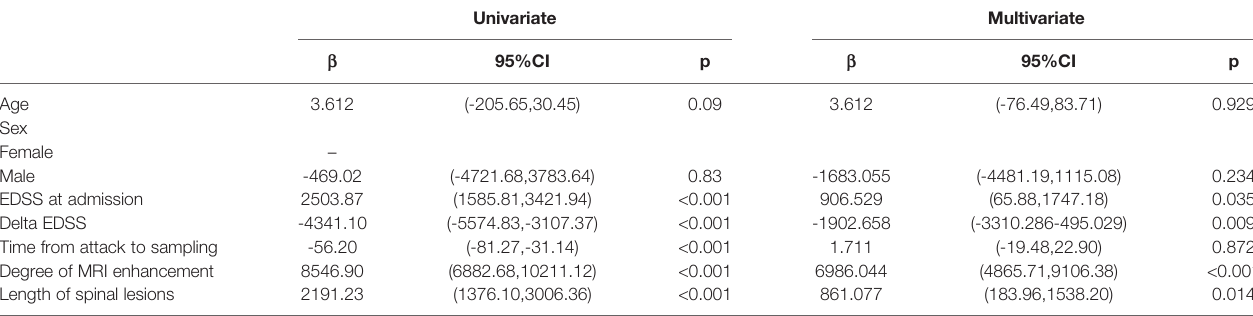
TABLE 3 | Univariate and multivariate models testing the correlations between RGMa levels and clinical parameters in patients with NMOSD. Univariate